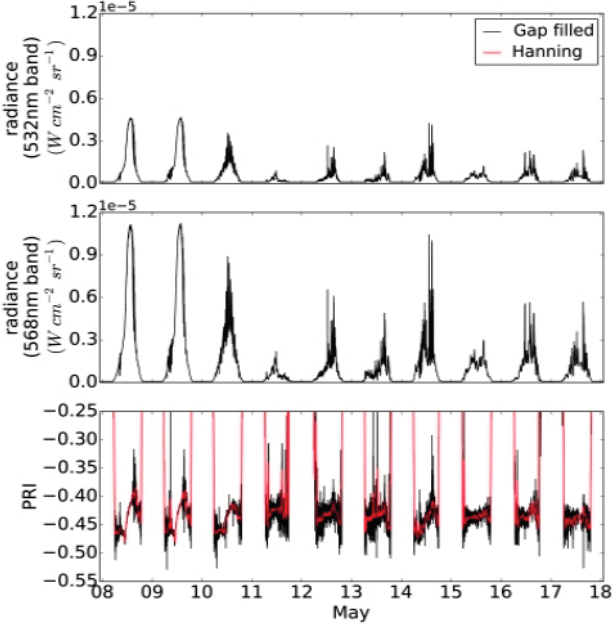
Figure 6. Graphs showing the calibrated radiance data in the 532 nm and 568 nm wavebands and the photochemical reflectance index (PRI). Dates shown are in the Pacific Standard Time zone ( i.e. ,